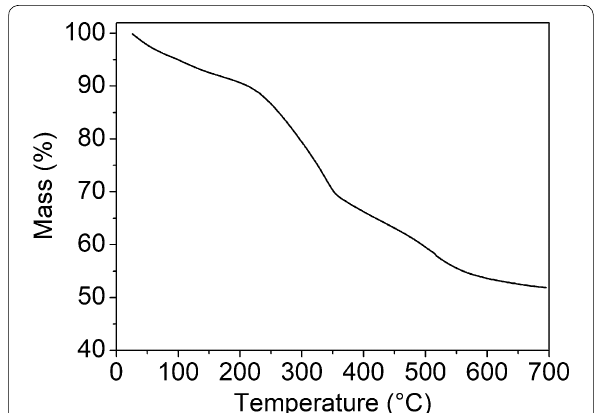
Fig. 4 Thermogram for EPS obtained from A. platensis